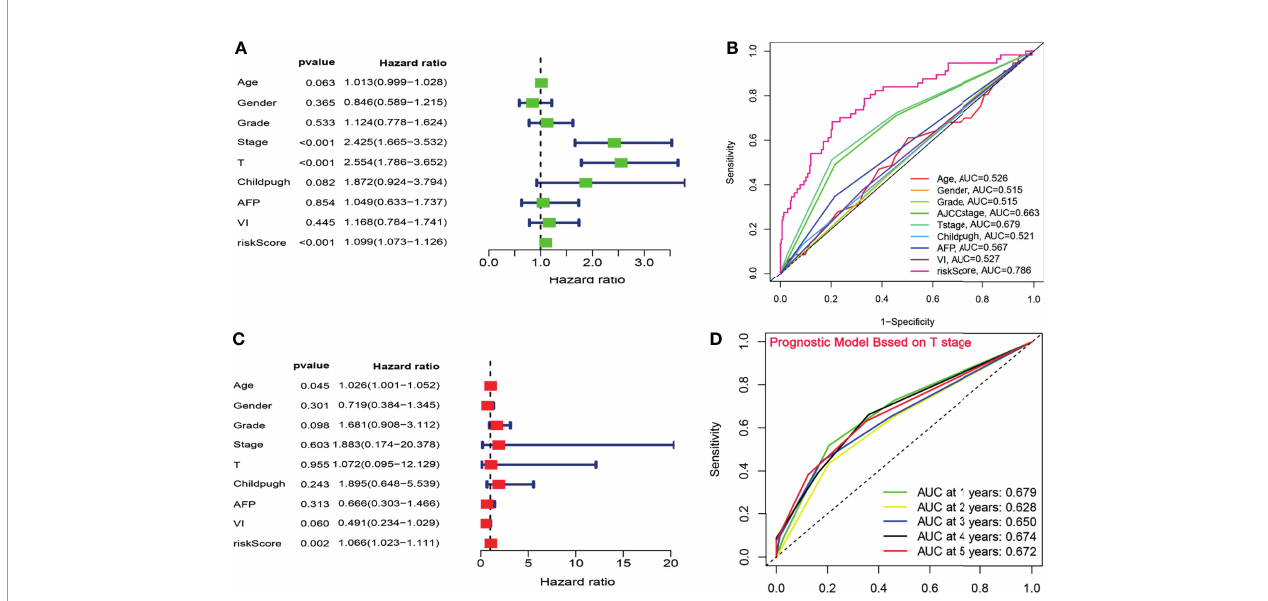
FIGURE 3 | The CCS-based risk score was an independent indicator. (A, C) The univariate and multivariate Cox analyses after adjusting for clinical factors. (B) ROC curve analysis for the prognostic accuracy of clinicopathological parameters. (C) The ROC analysis for several clinicopathological factors and the risk score. (D) Time-dependent ROC curves of T stage for prediction of the OS in TCGA cohort. ROC, Receiver operating characteristic; OS, overall